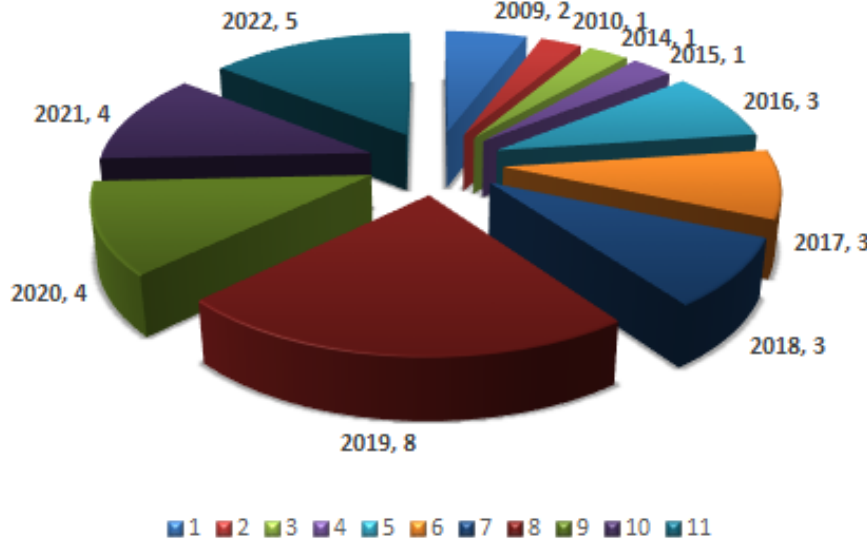
Figure 3. Number of papers collected per year.